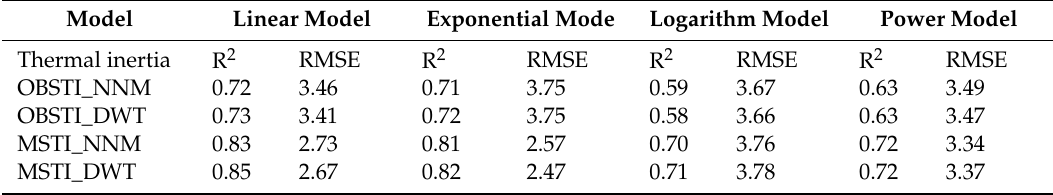
Table 1. The comparison of four models to estimate soil moisture content (SMC) using the 50 soil samples and leave-one cross validation for four combinations: OBSTI_NNM—the original-model-based bare STI using the 15 m resolution thermal infrared bands by re-sampling using the nearest neighbor method; OBSTI_DWT—the original-model-based bare STI using the 15 m resolution fusion thermal infrared bands; MSTI_NNM—the modified-model-based STI using the 15 m resolution thermal infrared bands by re-sampling using the nearest neighbor method; and MSTI_DWT—the modified-model-based STI using the 15 m resolution fusion thermal infrared bands. R 2 and RMSE (J · m − 2 · s − 1/2 · K ): coe ffi cient of determination and root mean square error between the estimates and observations of SMC.